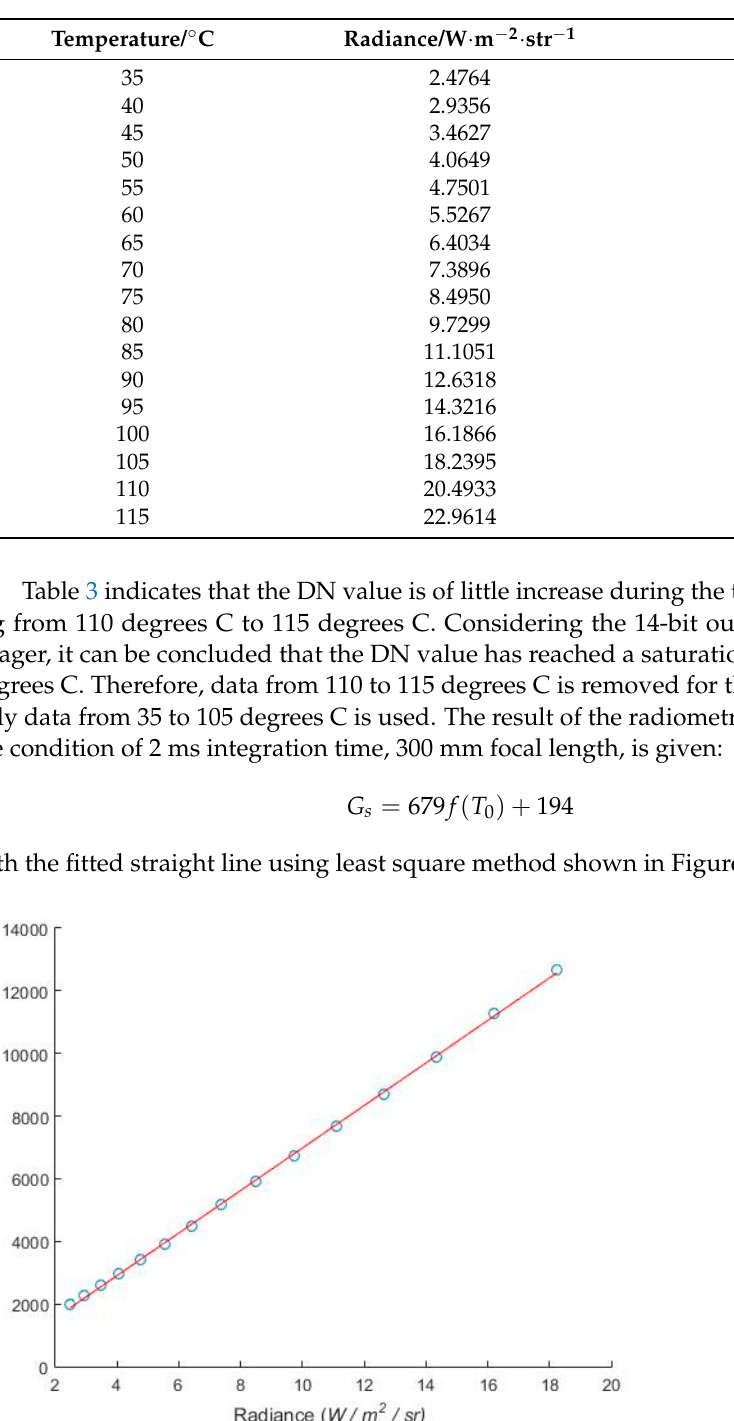
Table 3. Radiance and DN value collected in the radiometric calibration.